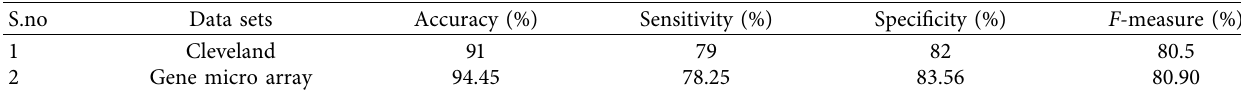
Table 11: Performance of proposed framework using medical